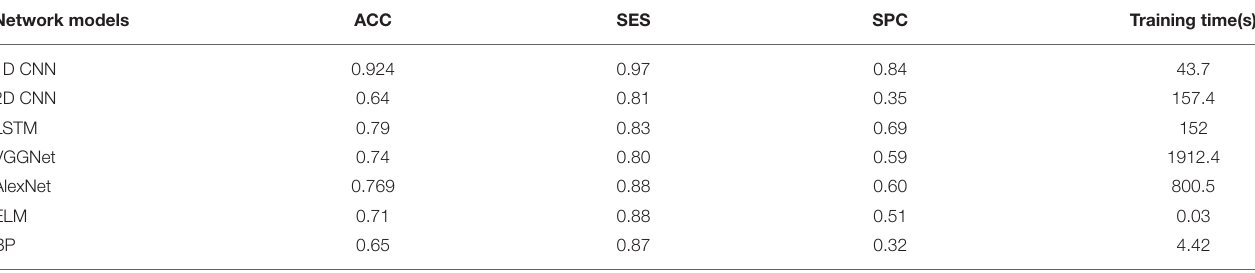
TABLE 3 | Results on running data set.